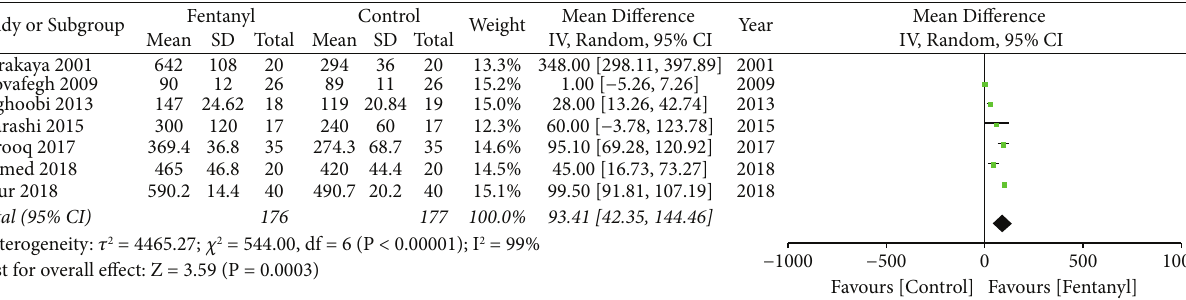
Figure 8: Meta-analysis of the duration of motor anesthesia between fentanyl and control groups.